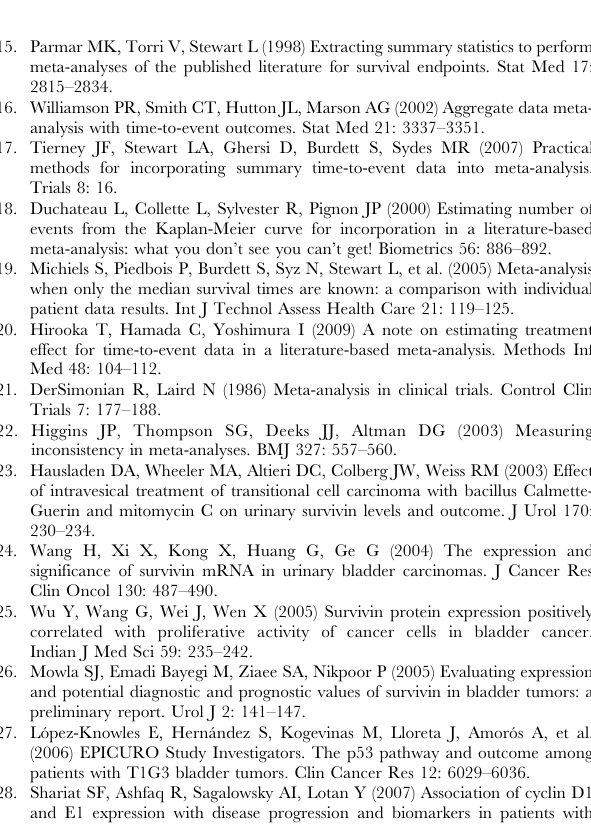
Table S2. Tumor characteristics. Table S3. Survivin expression according to pathological